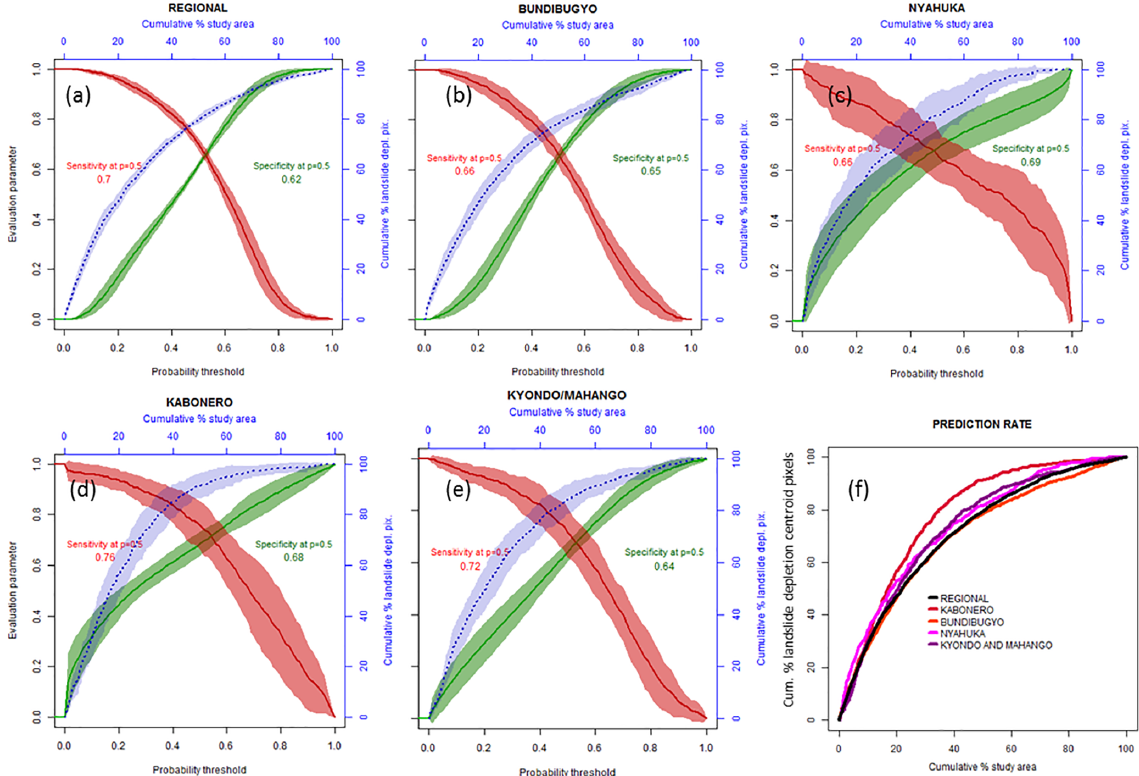
Figure 3. Model performance indicators for the selected model variants (indicated in bold in Table 2). (a–e) Sensitivity (red), specificity (green) and prediction rate curve (blue). (f) Mean prediction rates for selected models at the regional and local levels.